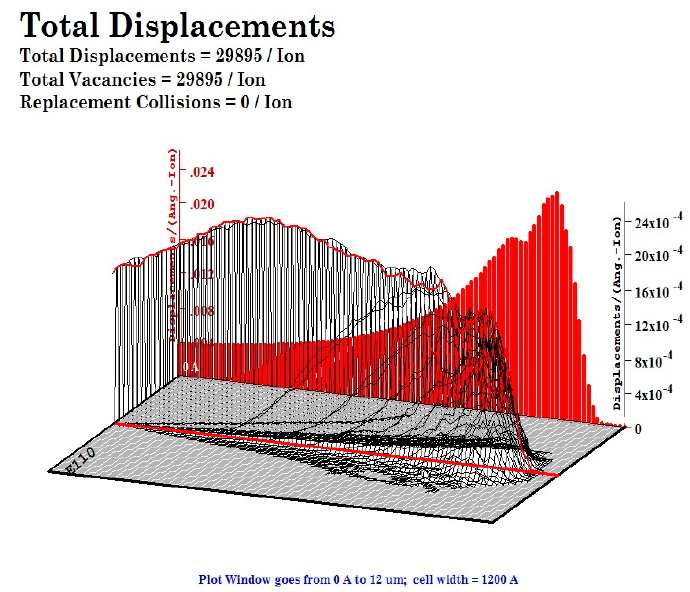
Figure 12. Damage caused by 120 MeV Rh in E110 alloy.